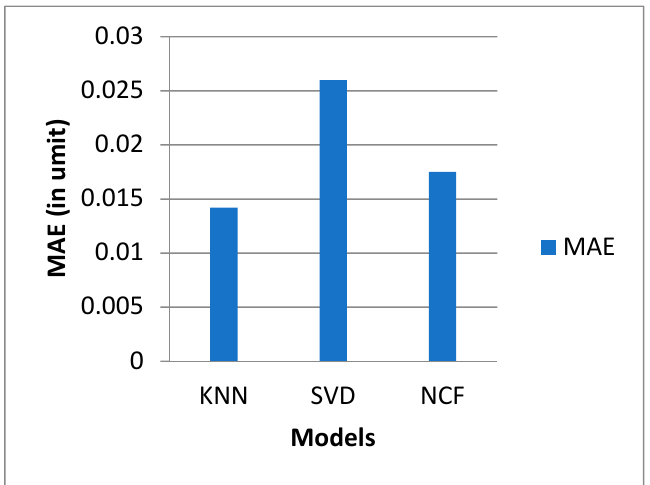
Figure 12. Comparative performance results of different models in terms of MAE, HR and ARHR in 70:30 training–testing scenario. Table 3. Performance evaluation of different models (in units) in 80:20 training–testing ratio.